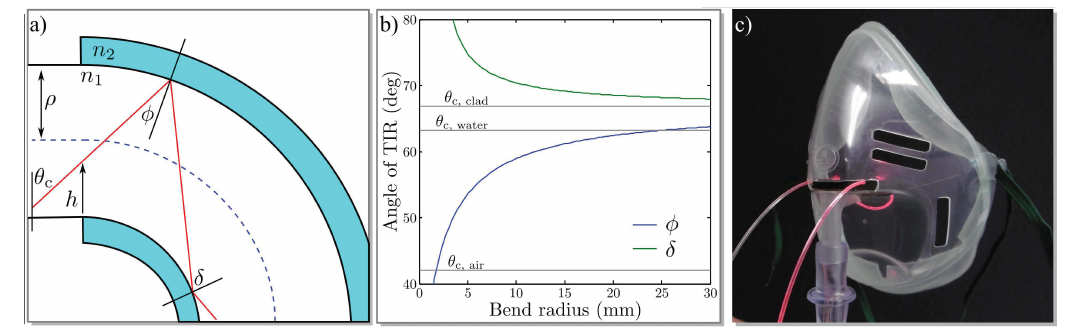
Figure 1. ( a ) Path of light inside the U-bend; ( b ) Angle of total internal reflection (TIR) over bend radius; ( c ) Photograph of the modified oxygen mask fitted with the U-bend humidity